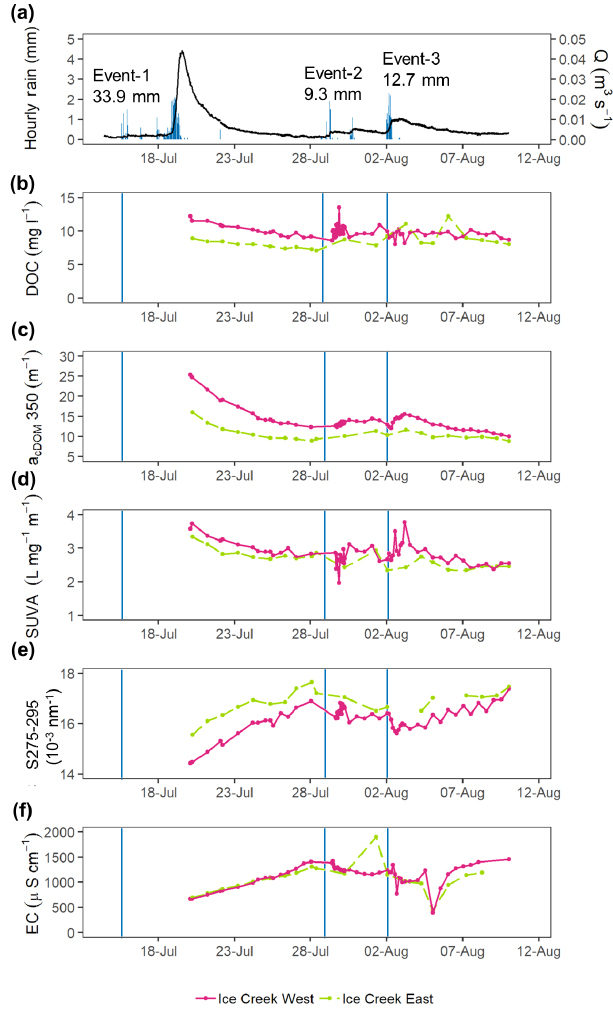
Figure 6. Time series from Herschel Island in 2016 show- ing (a) discharge (m 3 s − 1 ) and hourly rainfall (mm) from Ice Creek West, (b) dissolved organic carbon (DOC) concentra- tion (mgL − 1 ), (c) coloured dissolved organic matter absorp- tion at 350nm a cDOM 350 (m − 1 ), (d) specific ultraviolet ab- sorbance SUVA (Lmg − 1 m − 1 ), and (e) the cDOM slope S275– 295 (10 − 3 nm − 1 ) over the summer season in 2016 for Ice Creek West (magenta) and Ice Creek East (green) respectively. The on- set of rainfall events is marked with vertical blue lines. As de- scribed in the methods, DOC concentrations were corrected be- tween 30 July and 7 August. The scale depicts only S275–295 val- ues below 18 × 10 − 3 nm − 1 to capture the variability; hence the two outliers in Ice Creek East (Fig. 2) are not